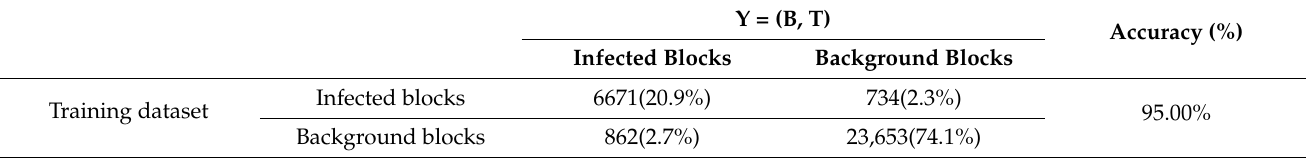
Table 4. Confusion matrix for training X-ray dataset of size 32 × 32